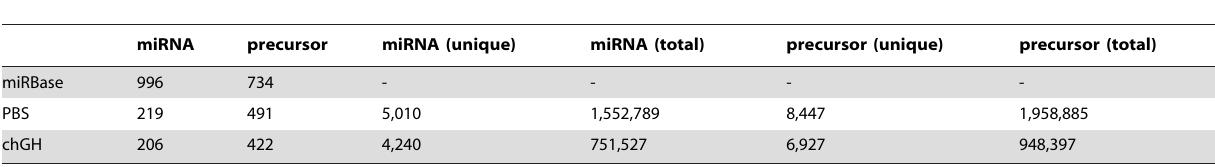
Table 7. Identification of known chicken miRNAs from chicken